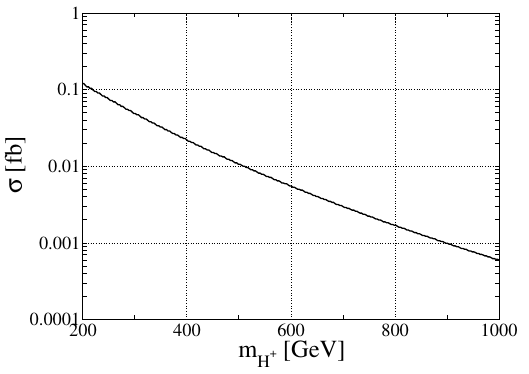
p s = 13 TeV. We take j (cid:16) u j = 0 : 01, j (cid:16) d j = 0 : 1, (cid:18) u = 1 : 2